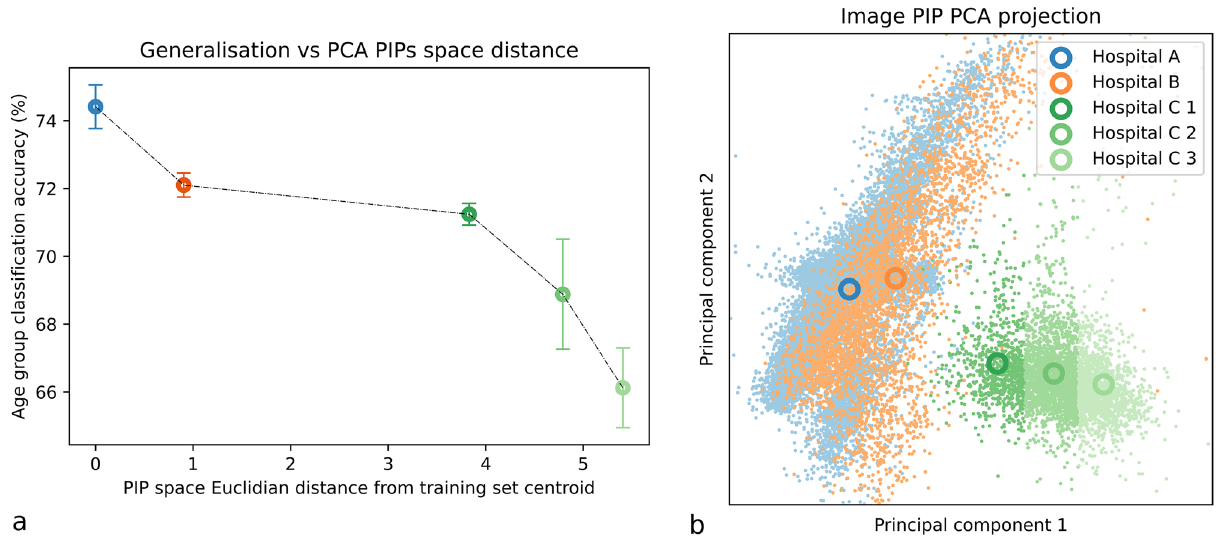
Figure 3. ( a ) Age group binary classification task validation accuracy results for each group. Hospital A is an I.I.D group where the validation set is a held out section of the training set. The other 4 sets are O.O.D sets from two other Hungarian hospitals. ( b ). Each point is the PCA projection of 12 image PIPs for a single medical image. Our results show that domain shift increases with change in the physical image generation parameters that technicians control. This is demonstrated for both inter and intra hospital scenarios. Legend on figure ( a ) is the same as for figure ( b ; pixels with intensities over 50 out of a possible 255 were set to 1 and under 50 were set to 0, and then the largest binarized connected area (always the tissue for our images) was kept. This removed all unwanted image markings in the mask. The original, unbinarized image was then multiplied by the binarized mask creating a version of the original image that was cleaned of markings. The cleaned images then underwent the Contrast Limited Adaptive Histogram Equalization (CLAHE) 30 algorithm. Images with breast tissue on the right side were then reflected along the y axis of the image so breast tissue was always set to the left side. See Fig. 2 row 1 for examples. Finally the images were downsampled to 244 × 244 pixels and pixel intensities were normalized to values between − 1 and 1. Downsizing images does often reduce model performance for medical imaging tasks with CNNs as there are features that are lost in this downsizing process 31 . However, in this study all images are downsized from the same initial dimensions (3000 px × 4000 px) so it is fair to assume the relative reduction in accuracy between each hospital should remain the same. 244 pixels per dimension is not far from the optimal range stated in 31 . The baseline networks were Image-net 32 pre-trained Resnets. They were trained with lr = 5 × 10 − 4 and batch size 32 on 2 Quadro RTX 45GB Nvidia GPU machines. All model training was implemented in PyTorch (1.10) 33 . Training sets contained 1000 images per age group from hospital A, this was chosen as a compromise of training times and size of generalization gap, we performed tests to test this and understand how the generalisation gap changes as training sets varied (See Supplementary Fig. S1. for analysis on training set size and generalization gap). Test sets were 150 images per age group for other hospitals. These test sets were randomly sampled within pre-defined groups based on PIP values see Fig. 3. As the task was binary classification, all test and train sets contained an equal number of samples from each age category. In this study we control for the known drivers of domain shift to understand how independent variation in PIPs translate to generalization error for deep neural networks. To control for population shift 34 we take images from the same country and ethnic group 35 . To control for selection bias 36 we make sure each data set is gathered with the same criterion, namely: the national mammography screening program in Hungary 37 , there is also sup- plementary open source data used for methodological validation. To control for annotation shift 34 we train our models on the proxy task of age group classification where we have perfect ground truth labels. The measured domain shift between the datasets can then be attributed almost purely to the variation in PIPs for each image. Age prediction from mammograms: Breast density is a measurement of the ratio between radiodense epi- thelium and stroma to radiolucent fatty tissue. Dense tissue has generally been associated with younger age and premenopausal status, with the assumption that breast density gradually decreases after menopause 38 . These visual features give grounds for the potential for age prediction from mammogram images. This potential was realized in 39 where the authors achieved a validation mean average error (MAE) of 8 years and was proposed as a tool for filling in missing tabular data. The networks were trained with the stochastic gradient descent (SGD) optimizer without augmentations with a cross entropy loss function;